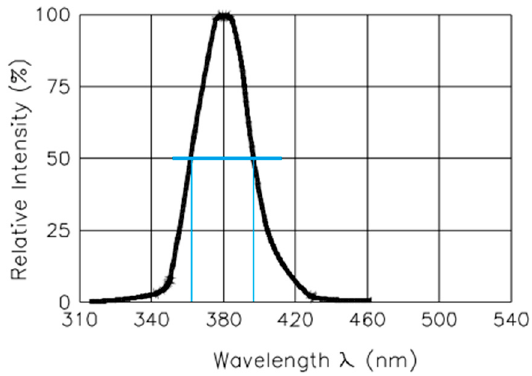
Figure 3. Emission spectrum of 385 nm LED (VAOL-5EUV8T4) [30].